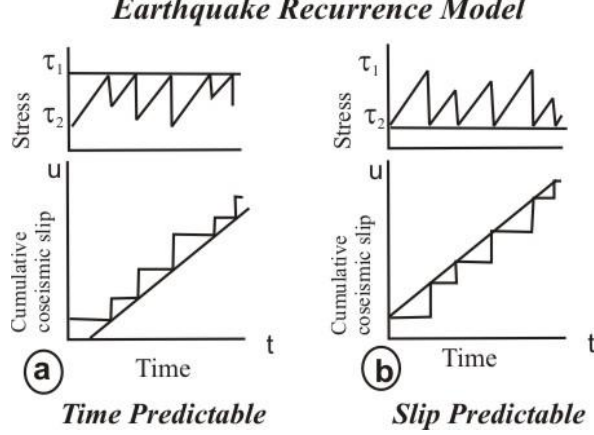
Fig. 1. Earthquake Recurrence Model: (a) time-predictable model showing stress buildup to a certain value ( τ 1 ) and non-uniform stress drop; and (b) slip predictable-model illustrating non-uniform stress buildup and stress drop to a certain minimum value ( τ 2 ) (after Shimazaki and Nakata,